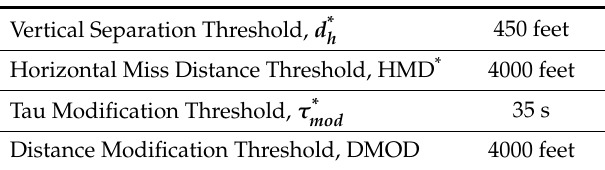
Table 2. Well clear thresholds.